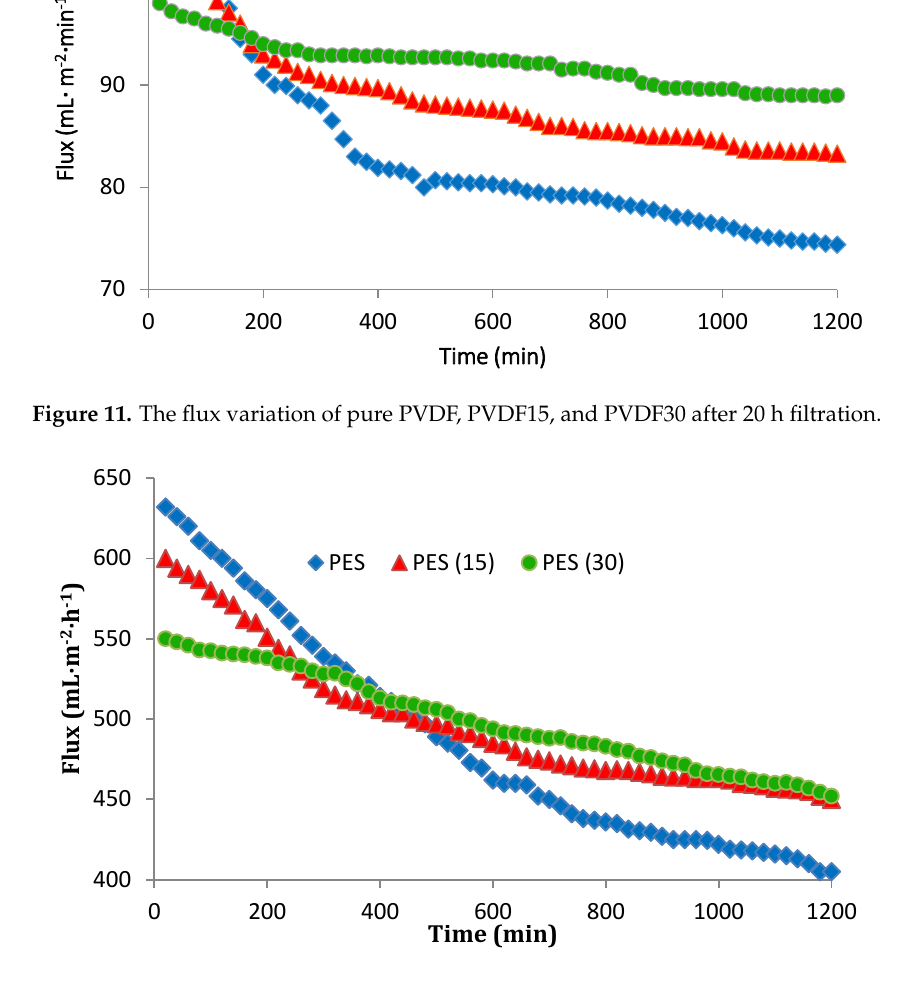
Figure 12. The flux variation of pure PES, PES15, and PES30 after 20 h filtration.